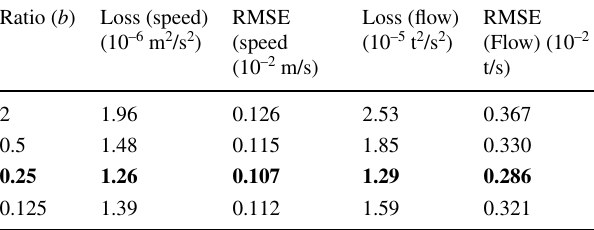
The bold values indicate superior metric values of the proposed